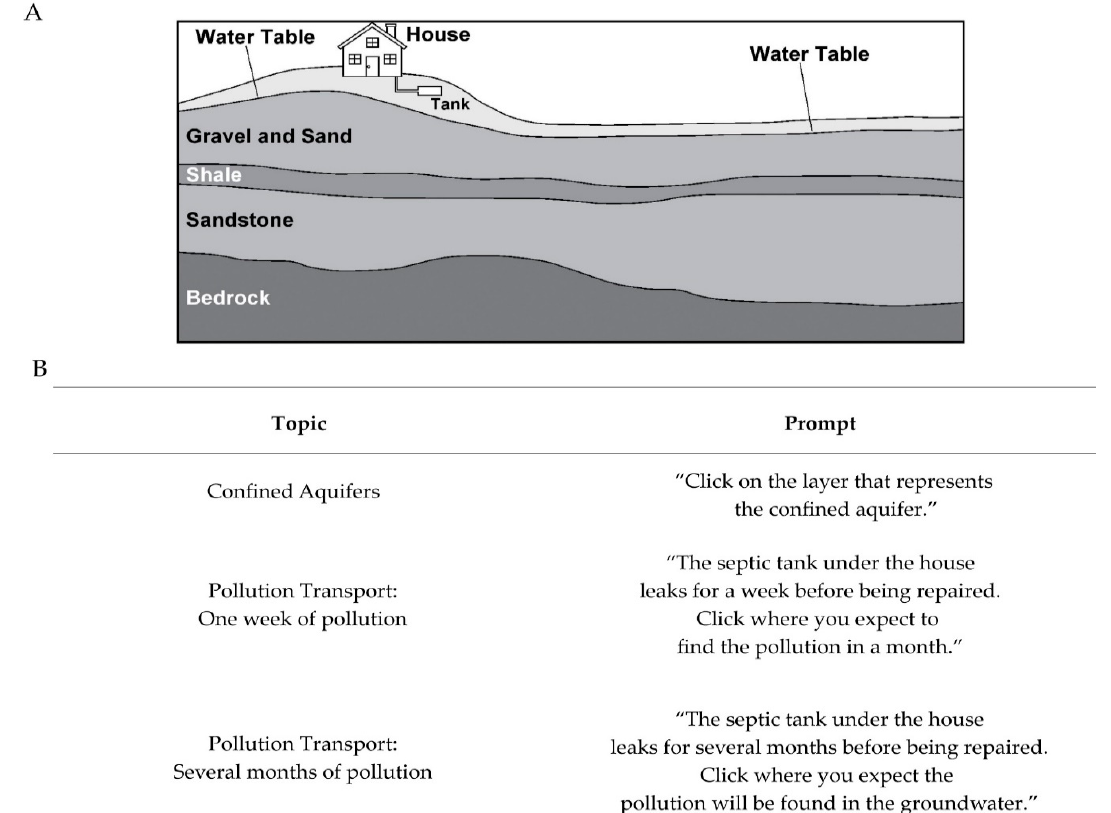
Figure 1. ( A ) Cross-sectional groundwater diagram used to probe students understanding of confined aquifers and pollution transport and ( B ) the corresponding prompts for each topic.